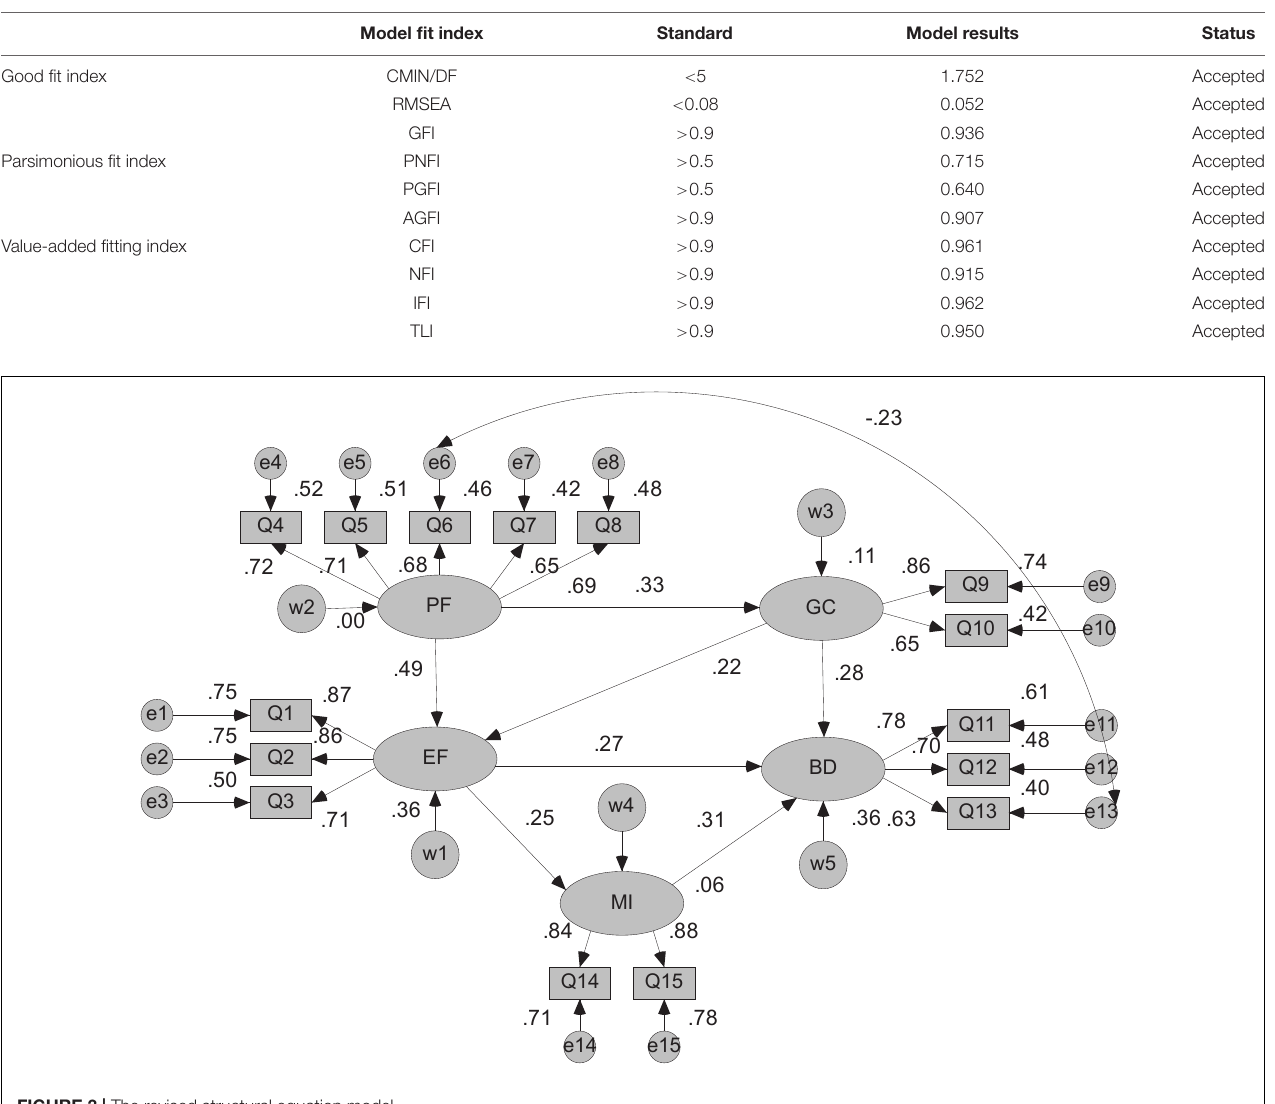
TABLE 6 | The results of the model fit.